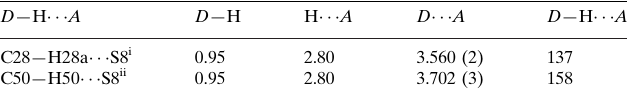
Hydrogen-bond geometry (A˚ , (cid:3)